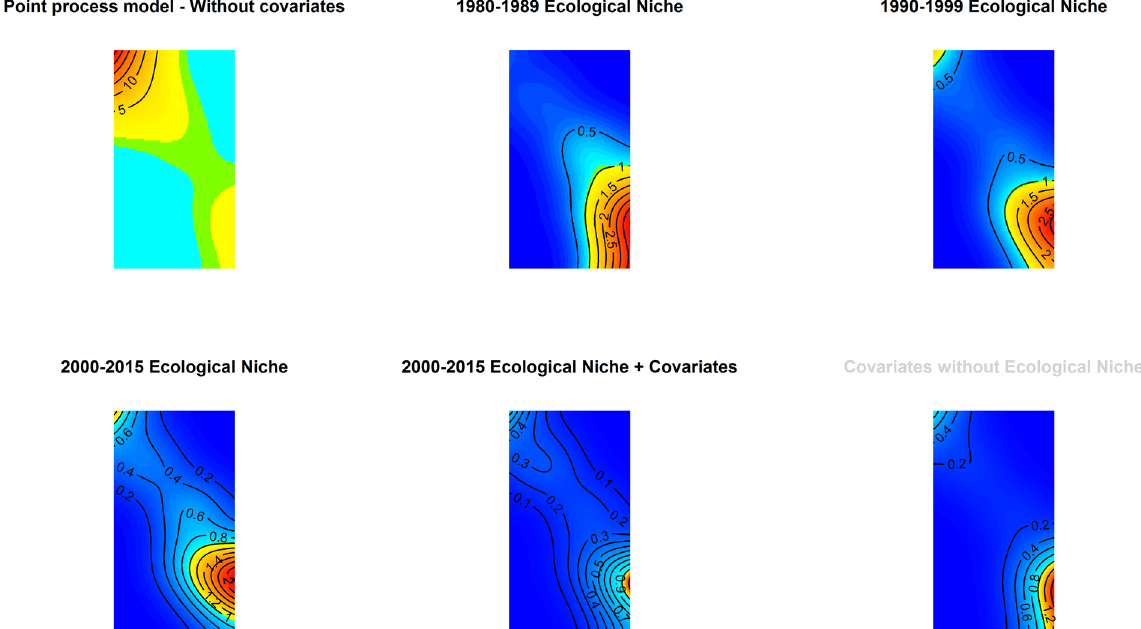
Figure 5. Smoothed residual plots. These plots demonstrate the degree of spatial autocorrelation in the inhomogeneous models of Hendra virus spillover incidents with each period-specific ecological niche of Hendra virus reservoirs ( Pteropus alecto and P. conspicillatus ) both unadjusted and adjusted for the human footprint, vegetation loss, and the woody